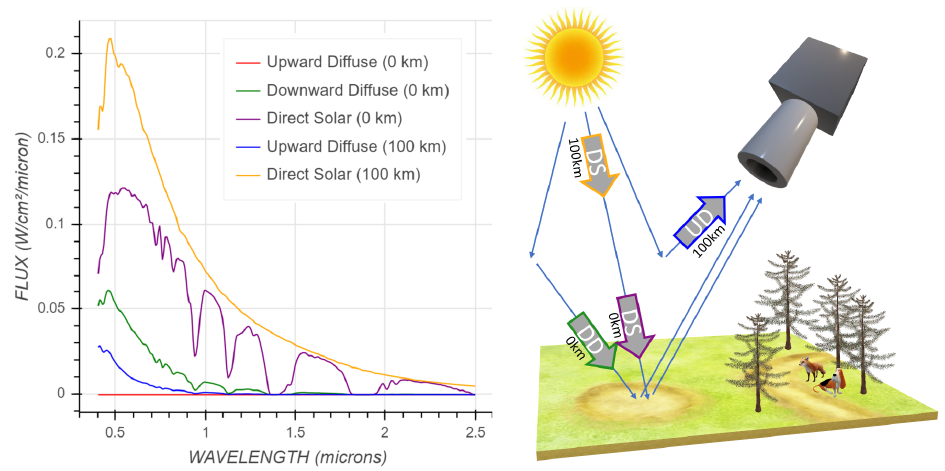
Figure 2. Components of the atmospheric radiative transfer model created using the MODTRAN online interface ( left ). The at-sensor radiance is the sum of all light entering the sensor, which is the result of these components and their interaction with the ground ( right ). The components shown in the left-hand figure were created using a Mid-Latitude Summer atmosphere model and a Rural aerosol model, with all parameters at default values for these models. The parameters correspond to the labeled paths on the right-hand figure: UD = Upward Diffuse,